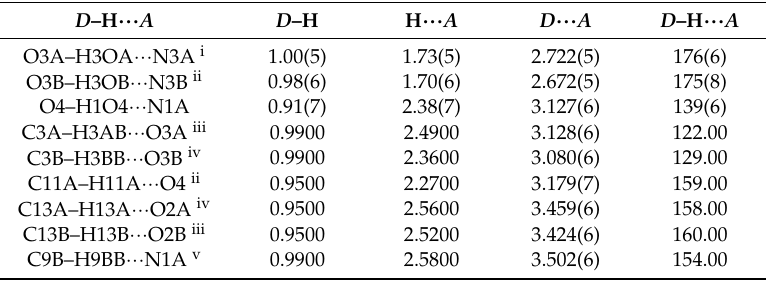
Table 1. Hydrogen-bond geometry (Å, °) of the title molecule 4 .